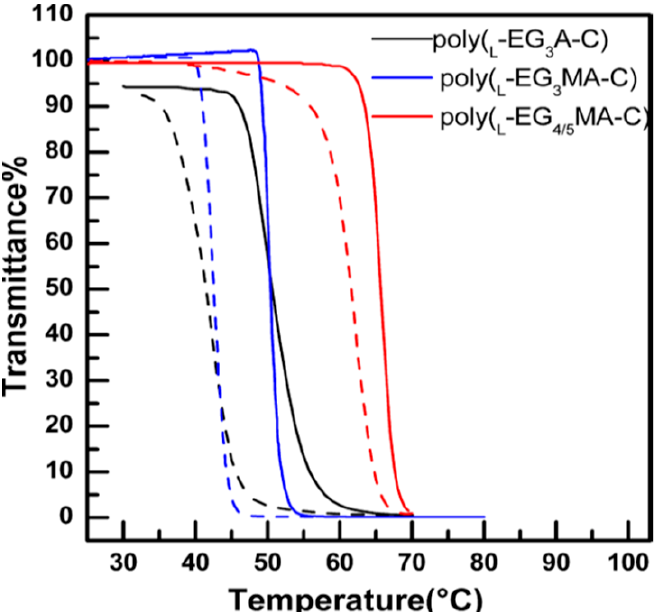
Figure 7. Plots of transmittance as a function of temperature for aqueous solutions (2 mg/mL) of (poly- L -EG 3 MA-C), (poly- L -EG 4/5 MA-C), and (poly- L -EG 3 A-C). Solid line: heating; dashed line: cooling. Reproduced with permission [35]. Copyright 2013, American Chemical Society.